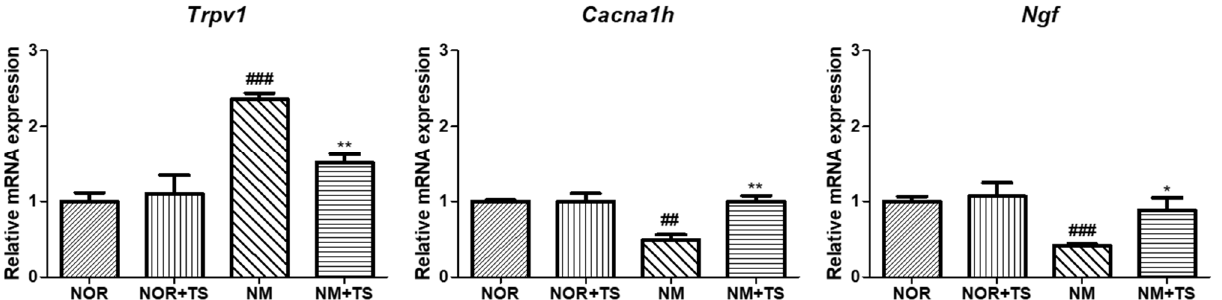
Figure 5. Comparison of gene expression of Trpv1 , Ngf , and Cacna1h in neomycin-treated HEI-OC1 Cells. Data are presented as means ± SEM of three independent experiments run in triplicate. ## p < 0.01, ### p < 0.001 (NOR vs. NM). * p < 0.05 ** p < 0.01 (NM vs. NM + TS).